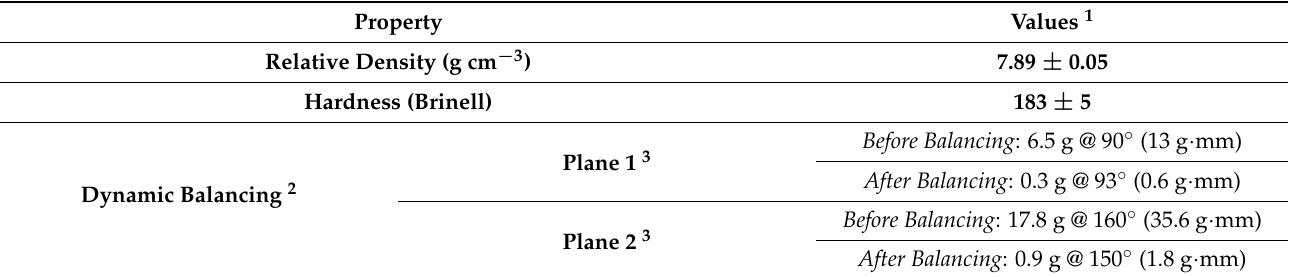
Table 3. Mechanical properties of the BJ impeller.